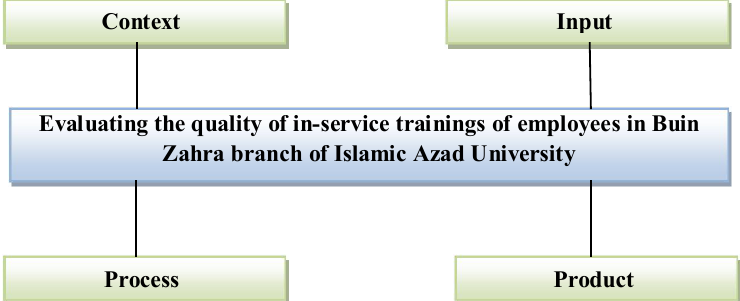
Fig. 1. Conceptual model of the research (author-designed)